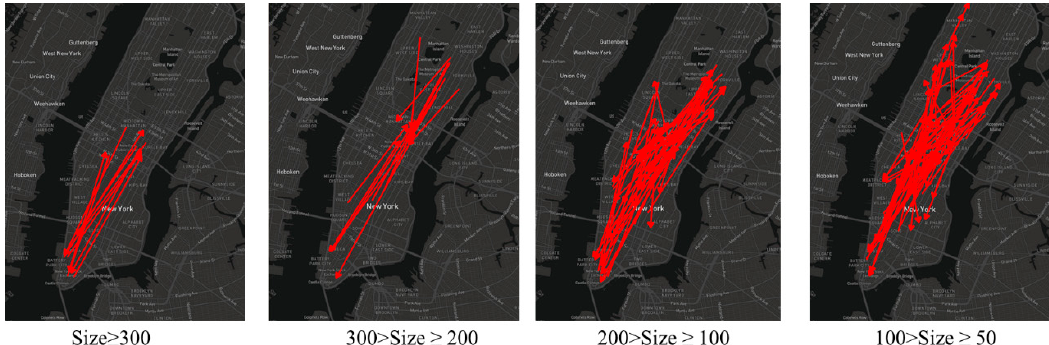
Figure 13. Top five flow clusters discovered by TOCOFC.